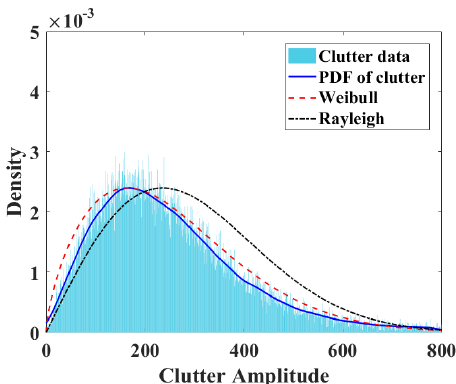
Figure 1. Sea clutter probability distribution obtained by OSMAR-S on 25 September 2015. Figure 1 is achieved using 44,318 samples of the background sea clutter taken from the radar spectra between the positive and negative first-order peaks at the 60th range bin on 25 September 2015. The significant wave height at this time was about 0.5 m. By fitting to the Weibull distribution, the estimated scale parameter is b = 282.05 and the shape factor is c = 1.76. The calculated PDF of the clutter and the fitted model of the Rayleigh distribution are also shown in Figure 1. It can be seen that the sea clutter data fit the Weibull